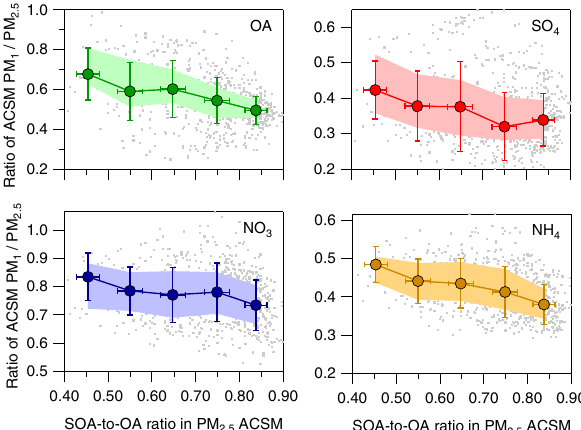
Figure 4. Relationship between the PM 1 / PM 2 . 5 ratios of aerosol species from the Q-ACSM measurements and the ratio of SOA to OA in PM 2 . 5 . The error bars refer to the standard deviation. The dots in grey are the raw data points corresponding to Fig. 2. The mean (filled circles), and 25th and 75th percentiles (lower and upper bands) are also